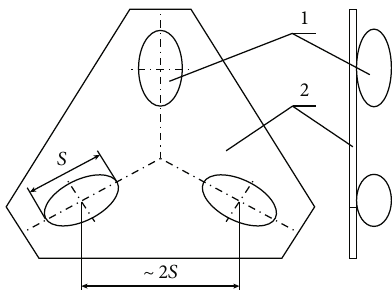
Figure 1: Flat seed unit [9]: 1: seed; 2: adhesive tape; S : seed